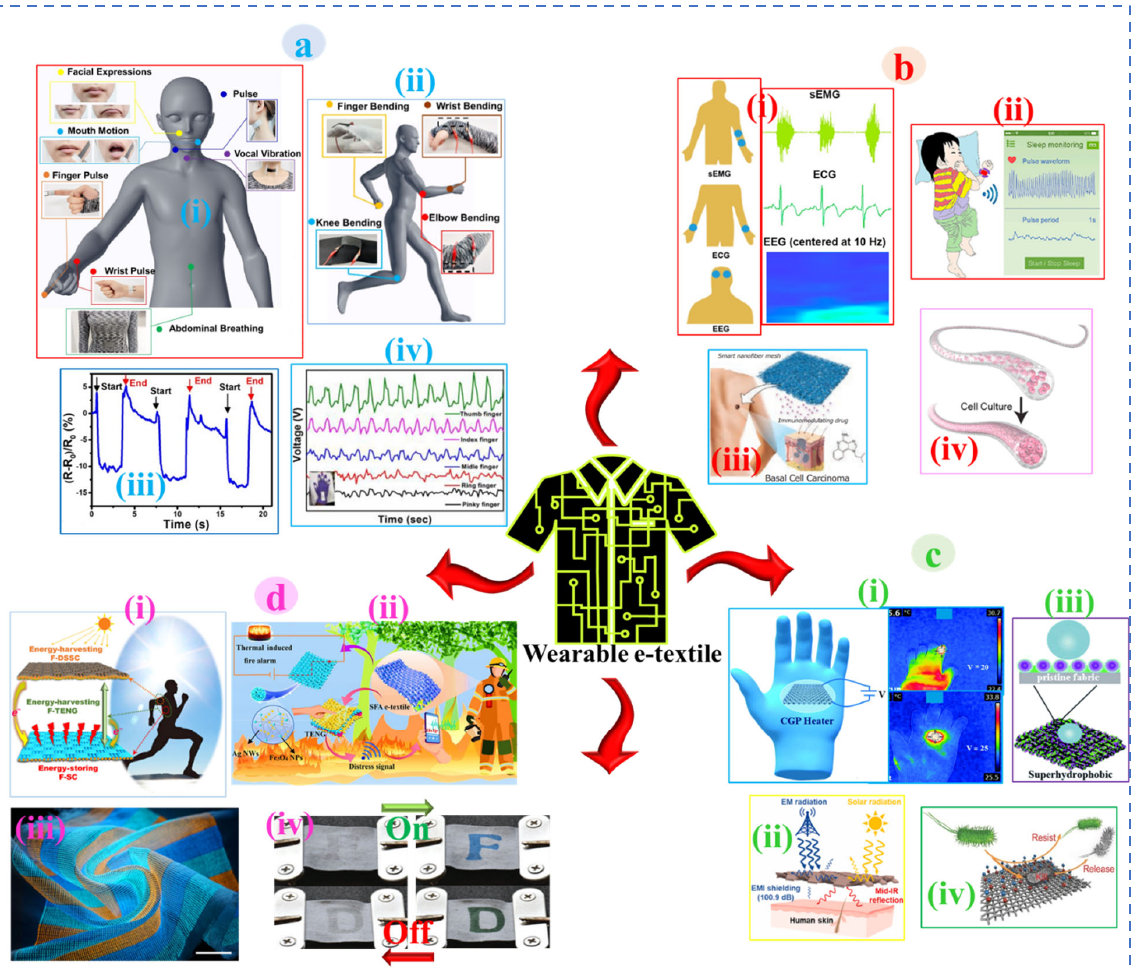
Figure 2. Different areas of application of e-textiles. ( a ) Human motion monitoring. (i) facial expression, vocal vibration, breathing, different pulse. (ii) different joints (finger, wrist, knee, elbow) motion, (iii) laughing. Reproduced with permission [133]. Copyright 2018, American Chemical Society. (iv) Signals originated from different finger bending. Reproduced with permission